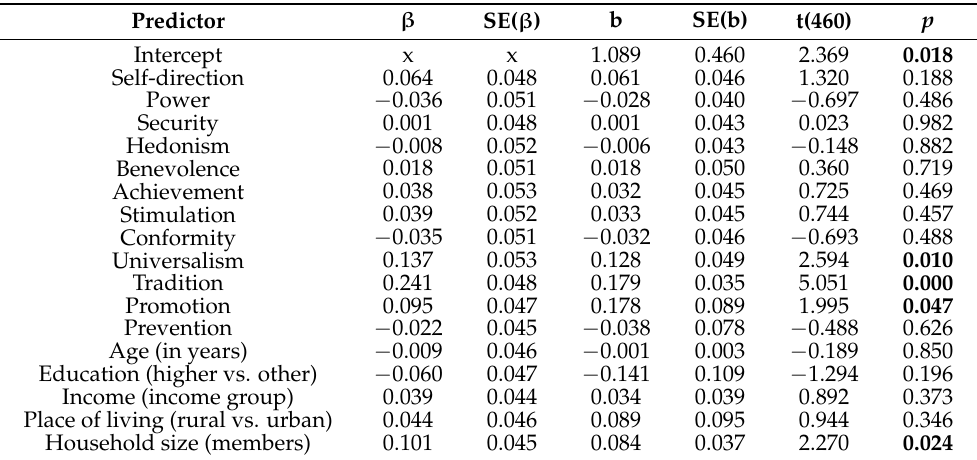
Table 11. The impact of the Schwartz values and regulatory focus on the WTP a price premium for domestic food products among men with control